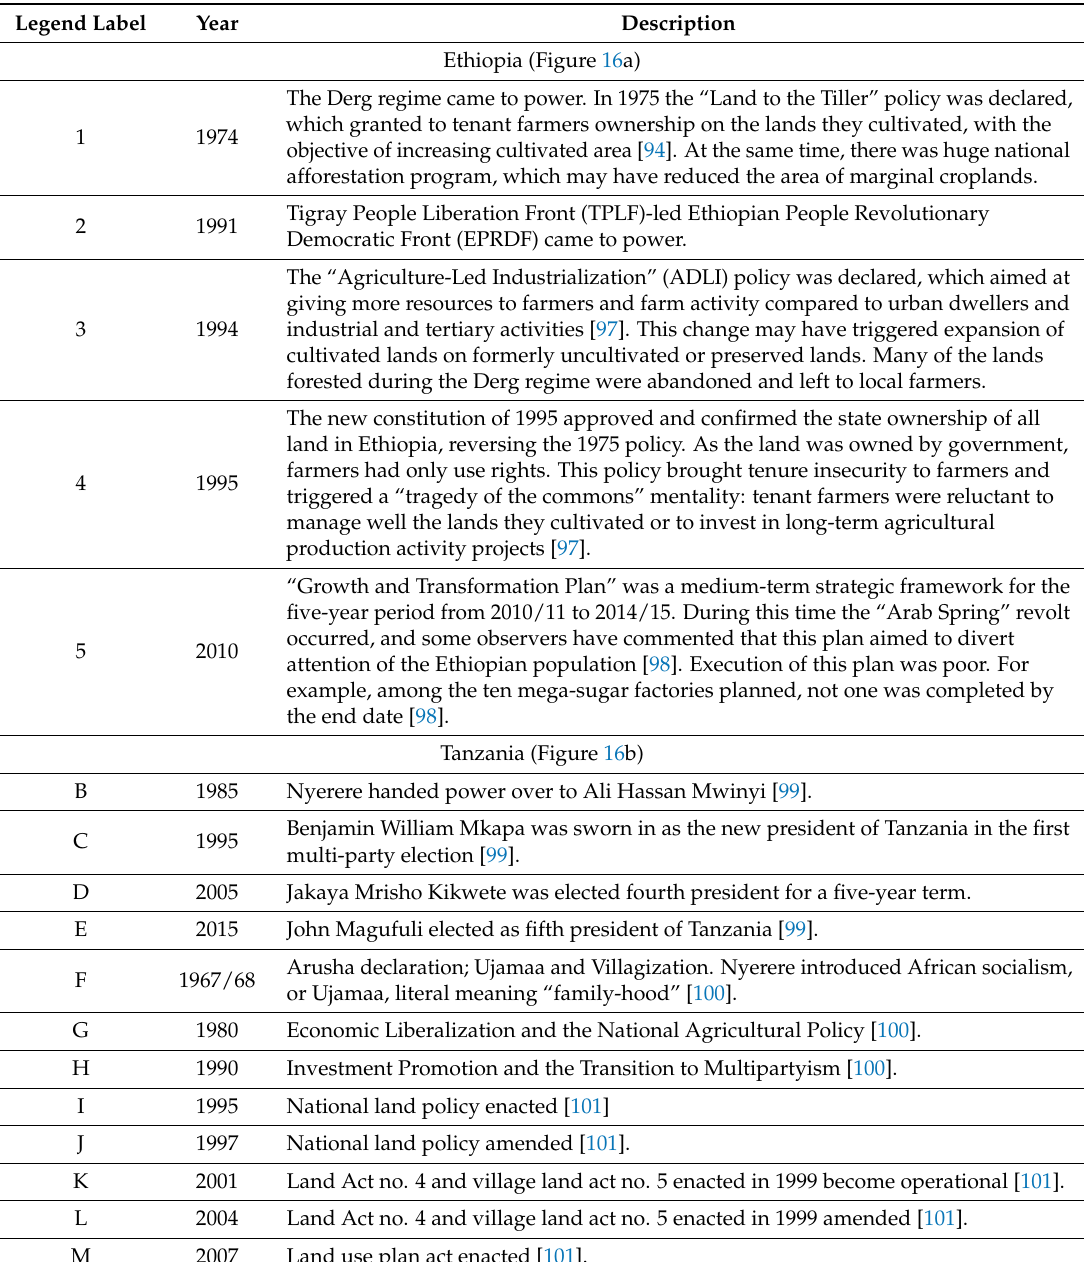
Table A1. Main institutional change periods and their description presented in Figure 17 legends for Ethiopia (Figure 17a) and Tanzania (Figure